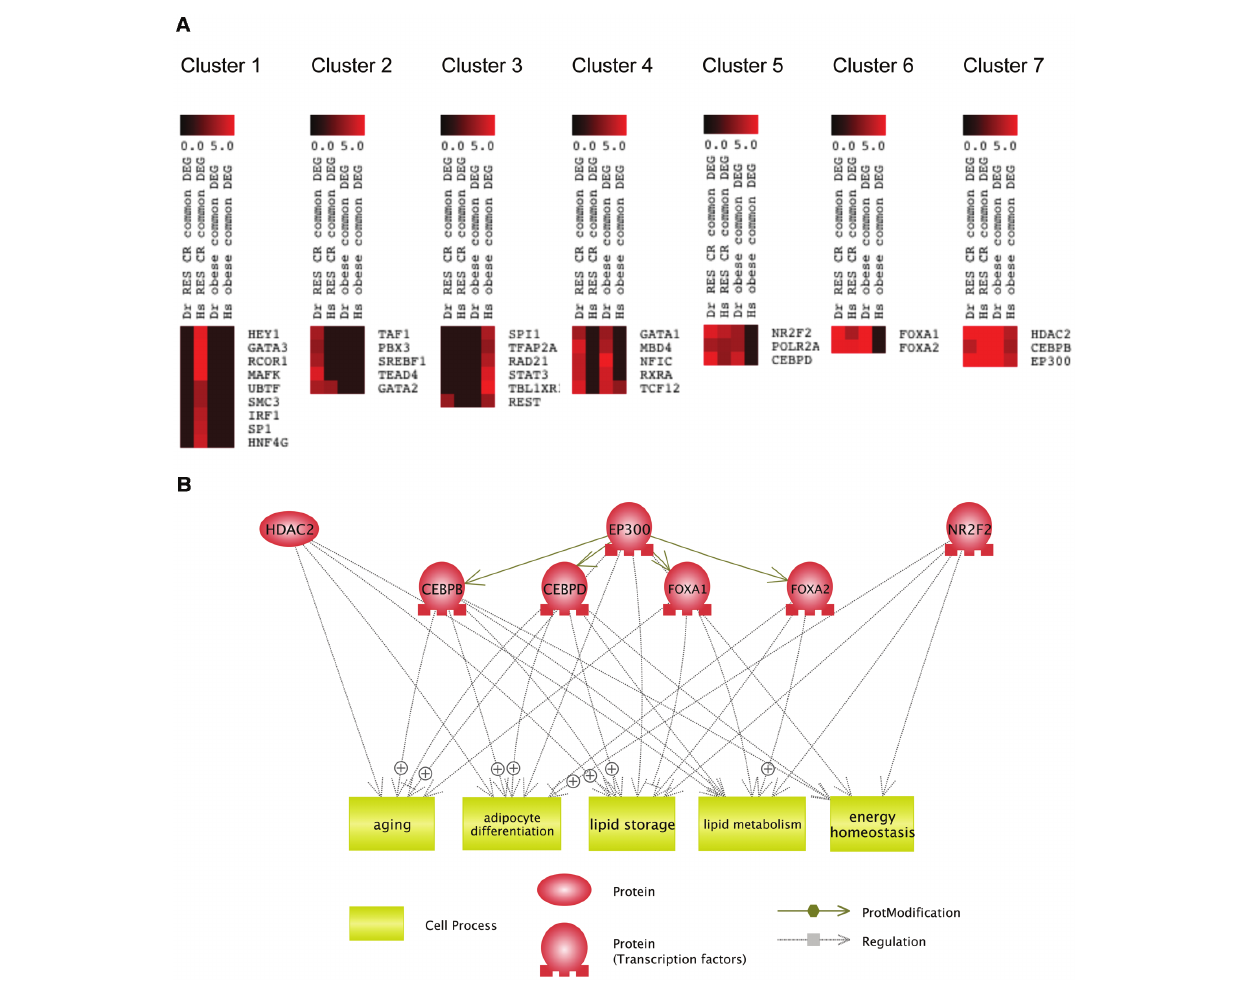
FIGURE 5 | Identification of common transcriptional regulators targeted by RSV and CR. (A) K -Means clustering of regulators identified by iRegulon based on their NES in each analysis. (B) Network between transcriptional regulators in Clusters 5, 6, and 7 and cellular functions enriched in these transcriptional regulators and the genes dysregulated in obesity and normalized by RSV or